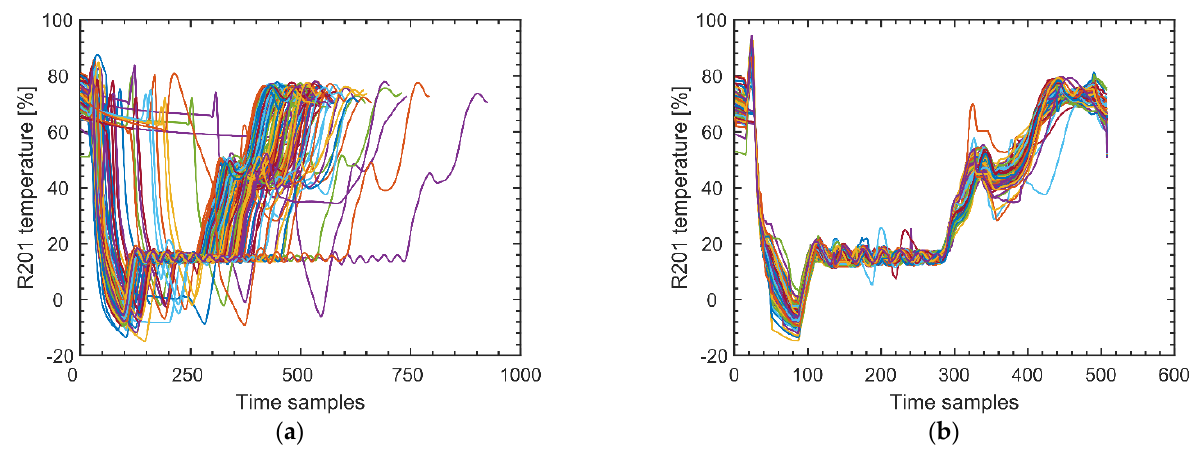
Figure 3. Alignment of R201 temperature profiles across several batches using dynamic time warping: ( a ) before alignment; ( b ) after alignment. The temperature units have been scaled for confidentiality reasons.